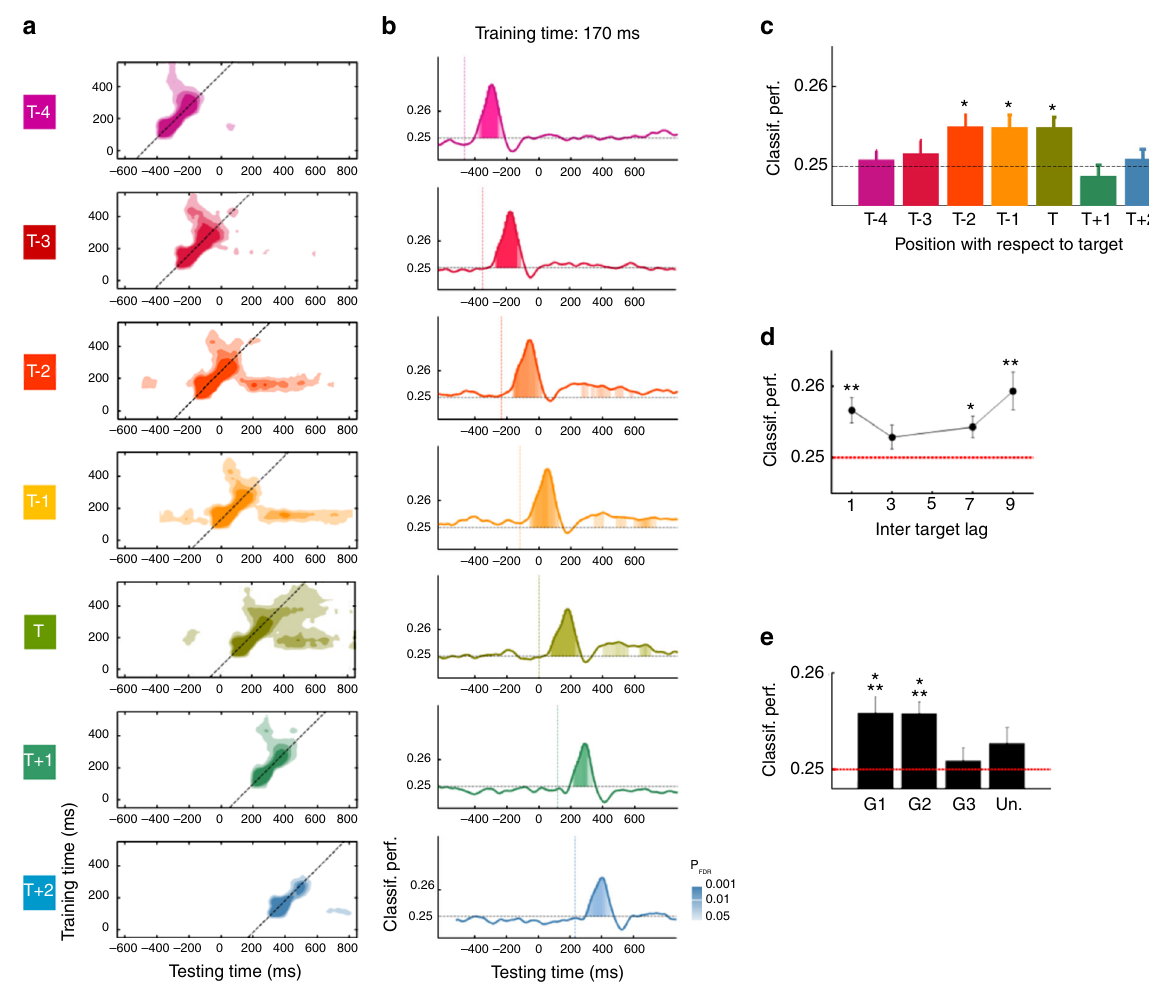
Fig. 4 Evidence for early gradual selection: early brain responses are selectively sustained over time as a function of target proximity. a Panels represent temporal generalization matrices for the target stimulus (T) and distractors at positions T − 4 to T + 2 at long inter-target lag. The color scale is as in Fig. 3a except that below-chance classi fi cation performance is not represented for visibility purposes. b Classi fi cation performance as a function of time for a classi fi er trained at 170 ms after stimulus onset. Filled areas represent time samples at which the classi fi cation performance was signi fi cantly different from chance (Signed-rank tests, corrected for multiple comparisons using FDR across stimulus positions, training times (170 and 370 ms) and testing times). Colored dotted lines represent stimuli onsets. c Mean classi fi cation performance of the same classi fi er but averaged over time (400 – 550ms). The dotted line represents chance. d Effect of inter-target lag. Classi fi cation performance averaged over Guess 1 and 2 and over time (400 – 550 ms) as a function of inter-target lag. e Effect of report. Mean classi fi cation performance between 400 and 550 ms for stimuli reported as Guess 1, 2, 3 and unreported stimuli. The red dotted line represents chance. Asterisks represent results from signed rank tests (* P FDR < 0.05; ** P FDR < 0.01; *** P FDR < 0.001, FDR corrected across stimulus positions). For display purposes, data points were smoothed using a moving average with a window of three